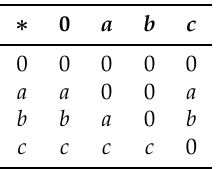
Table 1. Tabular representation of the binary operation ∗ .